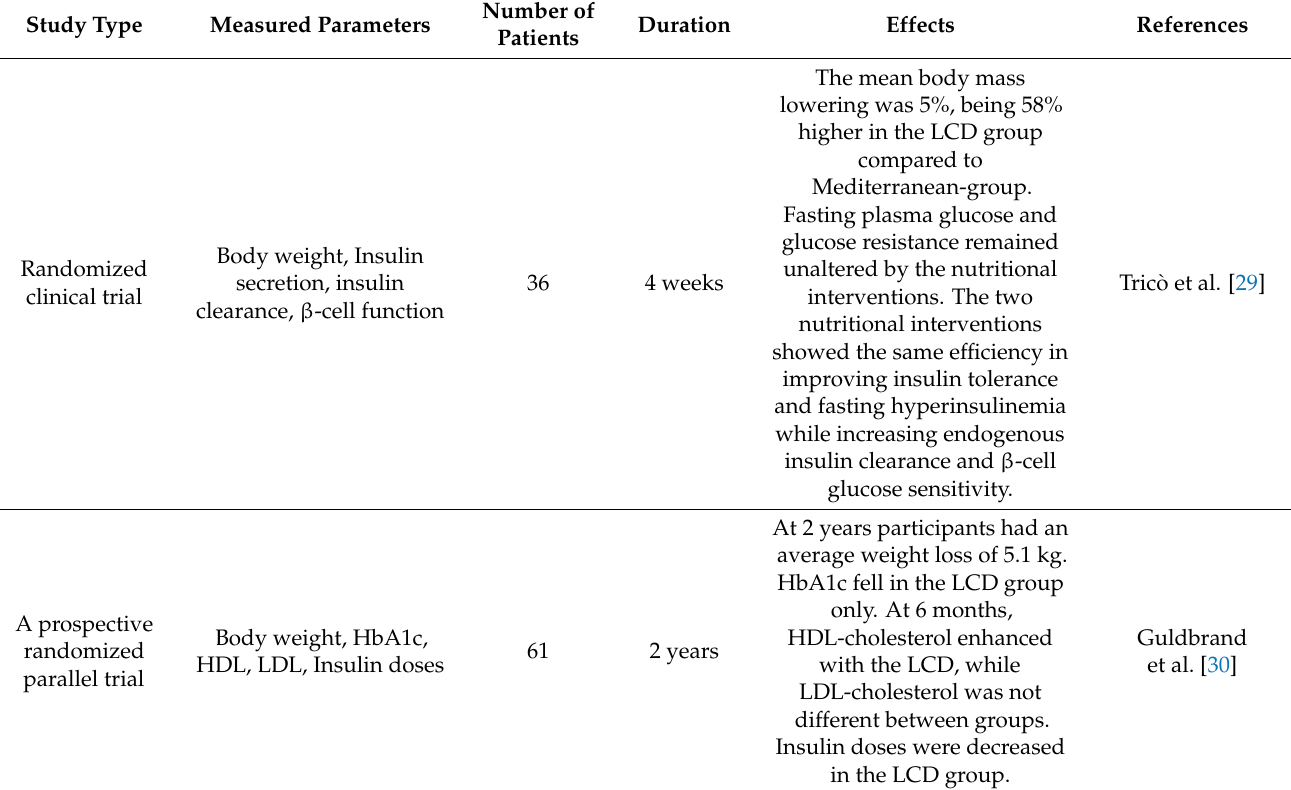
Table 1. Characteristics of the chosen studies.